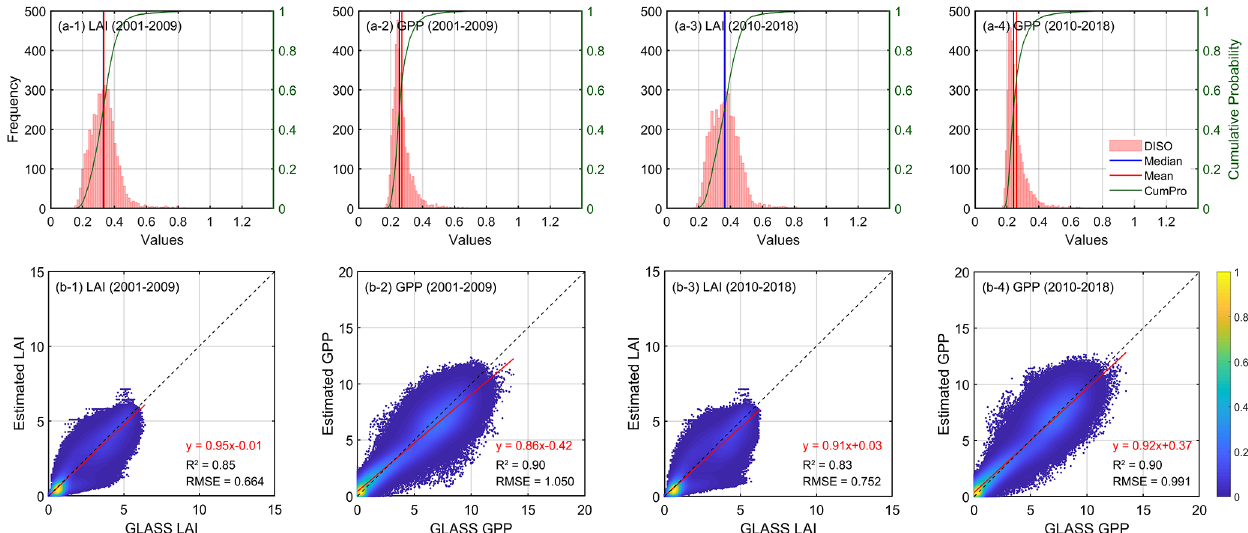
Figure 4. Validation of samples with optimal parameter schemes: (a) histogram statistics of DISO index for LAI (a-1, a-2) and GPP (a-3, a-4) , and scatter density plot of LAI (b-1, b-2) and GPP (b-3, b-4) against GLASS products on 8d basis. Some samples that do not converge during the MASM process and show anomalous high errors are excluded. The calibration years are from 2001 to 2009, while the validation is from 2010 to 2018. “CumPro” in (a) represents the cumulative